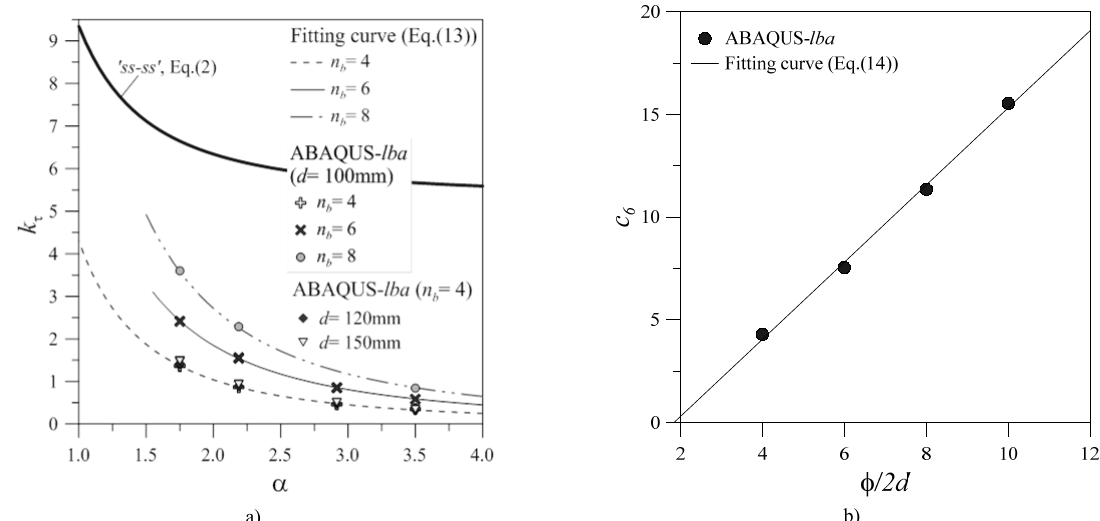
Fig. 7 FE numerically derived (ABAQUS/Standard) and analytical fitting curves for point supported glass shear walls. a) k  buckling coefficients and b) c 6 fitting curve.